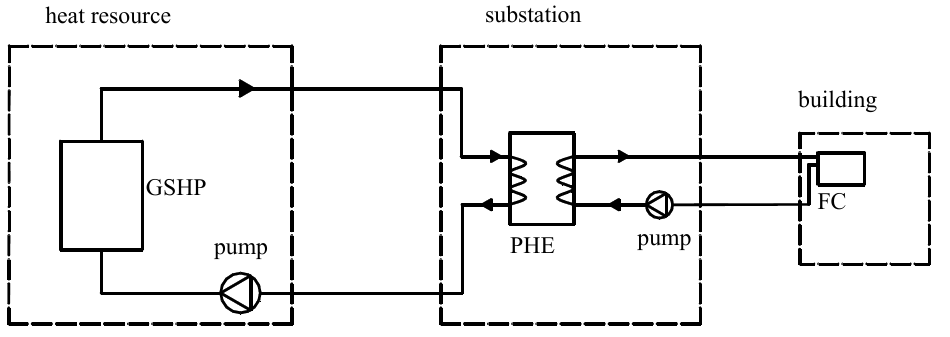
Figure 2. Schematic of the heating system. GSHP: ground-source heat pump; FC: fan coil.